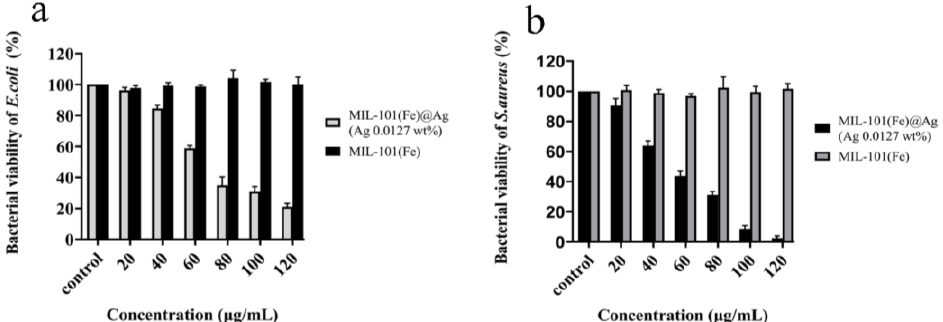
Figure 13. Results of plate-coating experiments with addition of MIL-101(Fe)@Ag (Ag 0.0127 wt%) and MIL-101(Fe) for inhibition of ( a ) E. coli . and ( b ) S. aureus